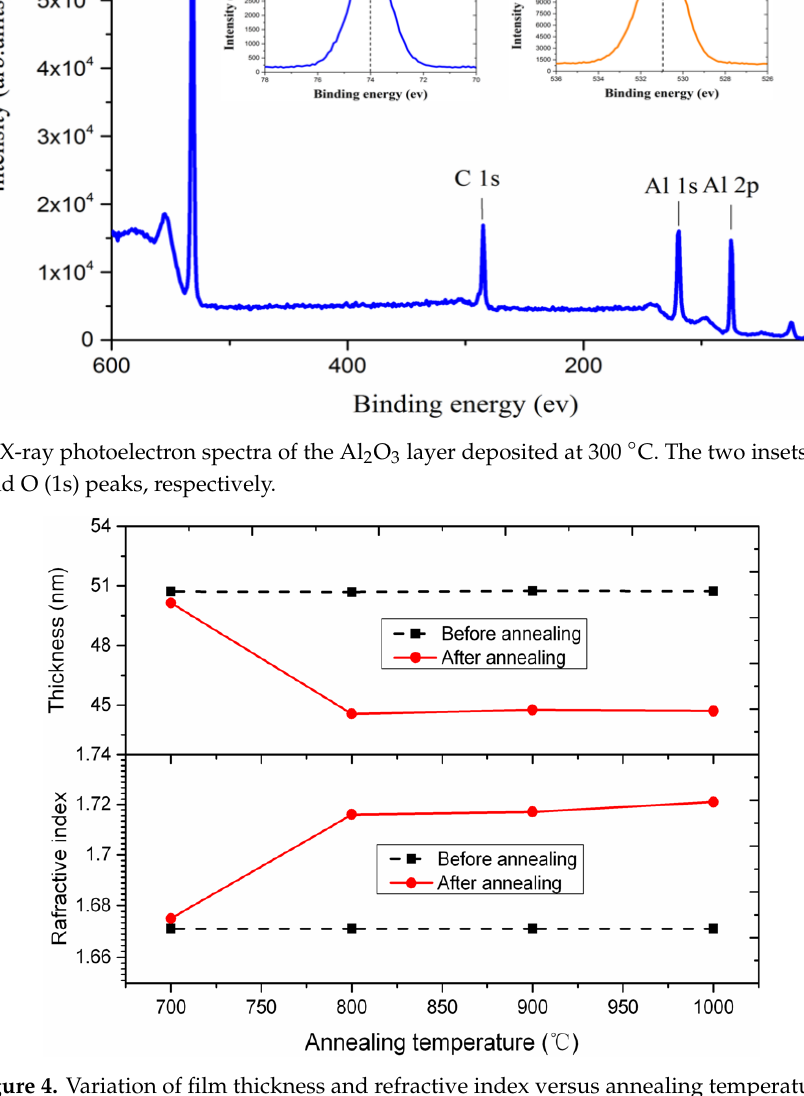
Figure 3. X-ray photoelectron spectra of the Al 2 O 3 layer deposited at 300 °C. The two insets show the Al (2p) and O(1s) peaks, respectively.